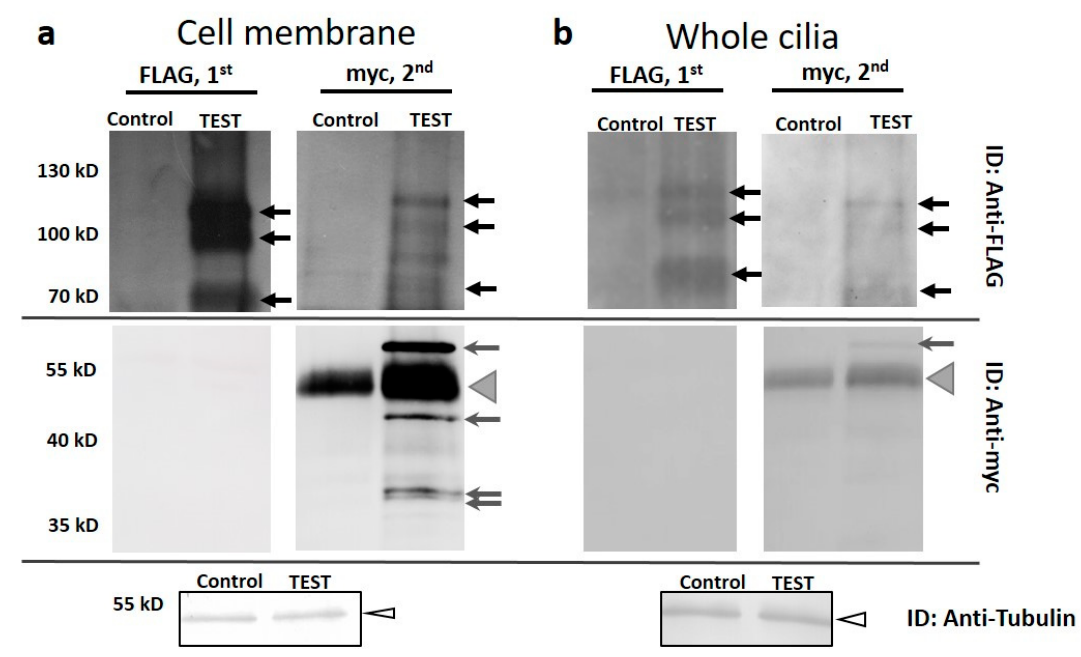
Figure 3. The XntA-myc protein can co-IP Pkd2-FLAG from solubilized cell membrane and whole cilia, however, the interaction occludes the FLAG epitope. IPs from isolated and solubilized ( a ) cell membrane or ( b ) whole cilia from cells expressing PKD2 -FLAG and XNTA -myc (TEST) or the FLAG and myc epitopes (Control). First IP done using FLAG a ffi nity agarose (FLAG, 1 st ) and after removal of the FLAG a ffi nity agarose, the second IP from the same supernatant used myc a ffi nity agarose (myc, 2 nd ). The resulting blots were used to probe for the Pkd2-FLAG protein (ID: Anti-FLAG; upper blots, black arrows) followed by stripping the blots and probing for the XntA-myc protein (ID: Anti-myc; lower blots, grey arrows). Note: the myc IP’s show the heavy chain of the antibody at 50 kD (grey arrow heads) and should be ignored. IPs targeting Pkd2-FLAG did not co-IP XntA-myc (ID: Anti-myc blots, FLAG, 1 st TEST lane). The IPs targeting XntA-myc (ID: Anti-FLAG blots, myc, 2 nd TEST lane) produced both XntA-myc (grey arrows, ID: Anti-myc) and Pkd2-FLAG (black arrows, ID: Anti-FLAG). Before solubilization, TEST and Control protein samples were equalized for protein amount and volume. Five µ L was removed from both TEST and Control samples before solubilization and detected in a western blot using Anti-Tubulin (arrow heads, ID: Anti-Tubulin). Experiments were repeated three times for cilia and for cell membrane, representative blots are shown.